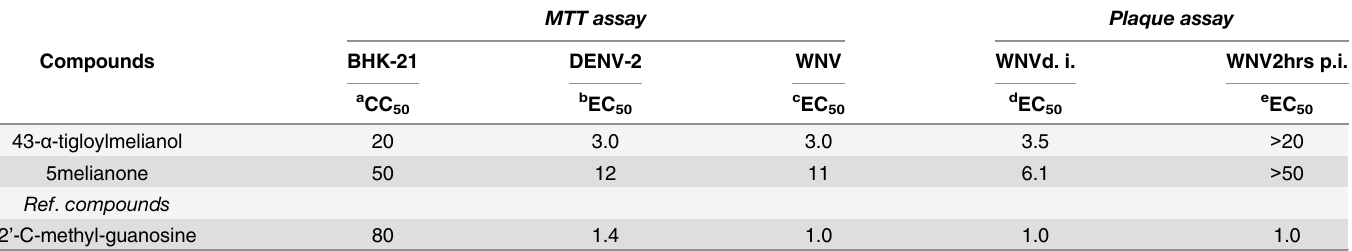
Table 2. Cytotoxicity and antiviral activity of 3- α -tigloyl-melianol and melianone against DENV-2 and WNV.